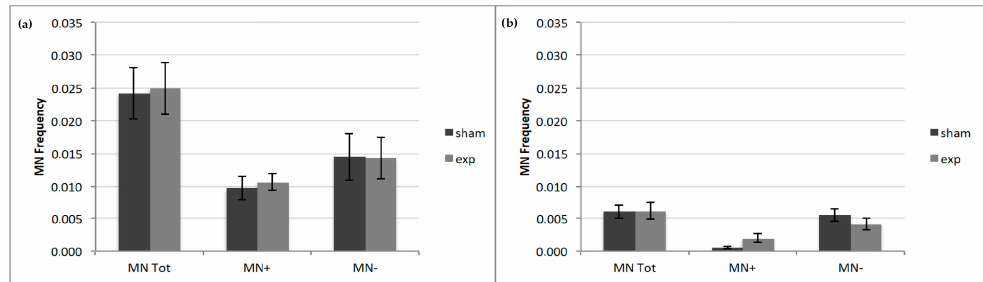
Figure 2. CREST analysis on HDF exposed to 2.45 GHz. No significant increase in MN tot or in the frequency of MN + and MN − in 2.45 GHz CW ( a ) and PW ( b ) exposed, with respect to sham samples were observed. Data are representative of four experiments, and bars denote the standard error.